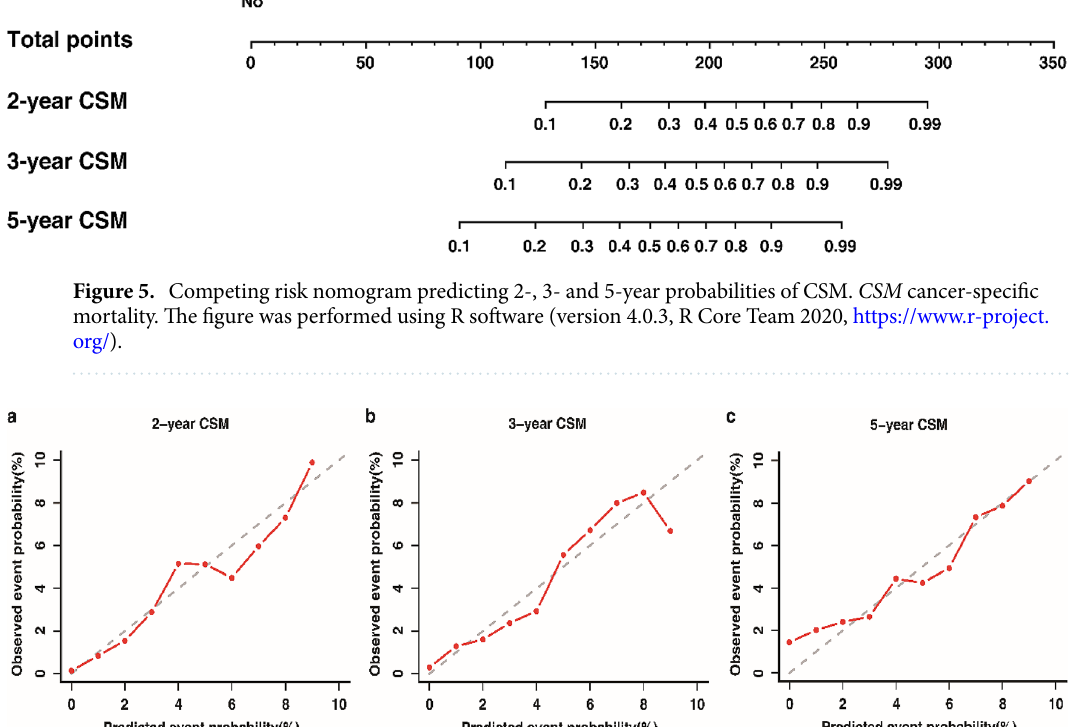
Figure 6. The calibration curves of the predicted probabilities and observed CSM rates. The 45-degree diagonal represents perfect agreements between the nomogram-predicted probabilities (X-axes) and the observed CSM rates (Y-axes). CSM cancer-specific mortality. The figure was performed using R software (version 4.0.3, R Core Team 2020, https:// www.r- proje ct.